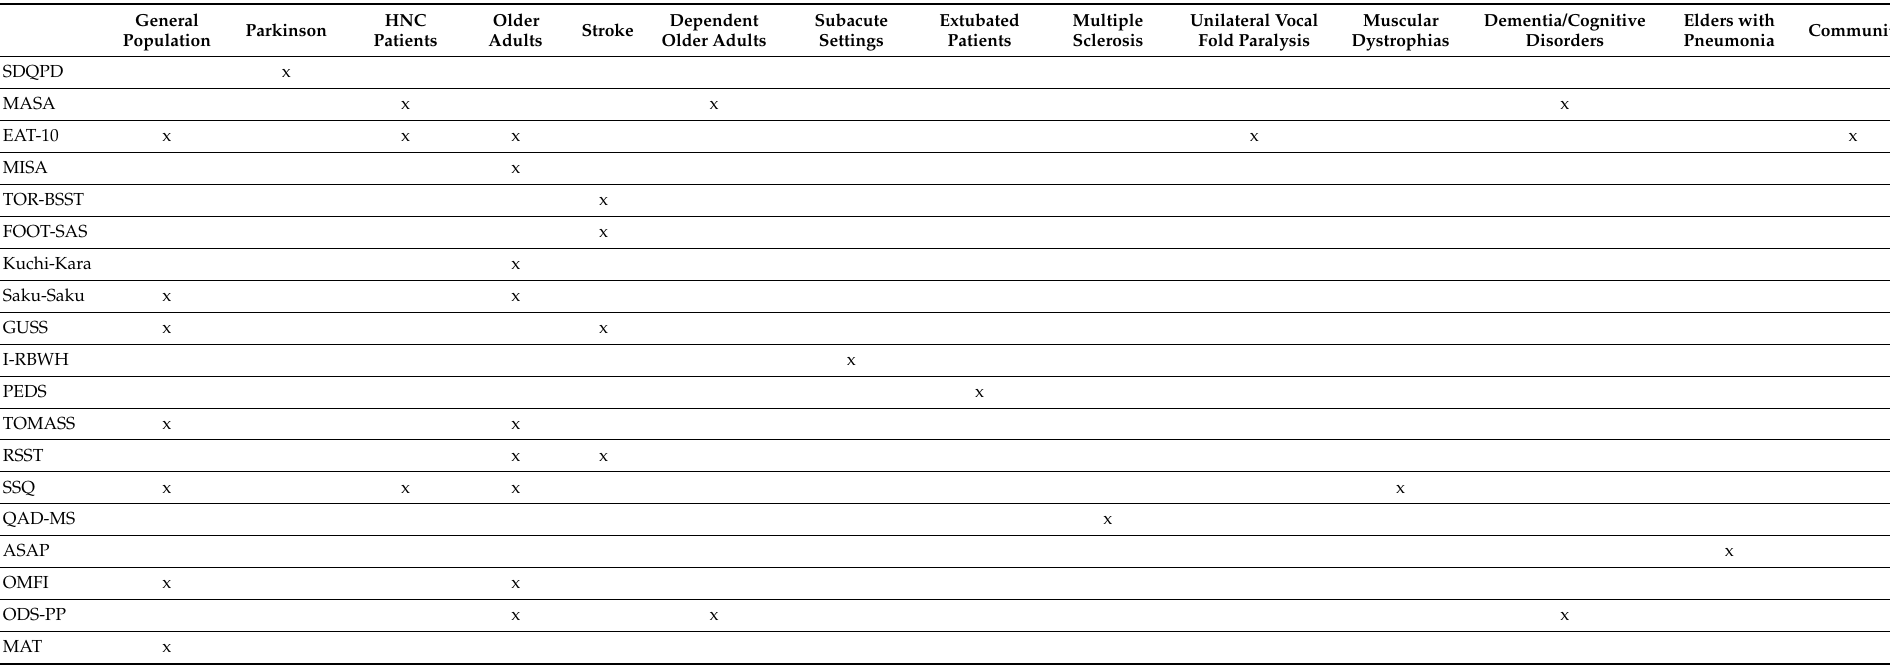
Table 4. Contexts where OD screening instruments are